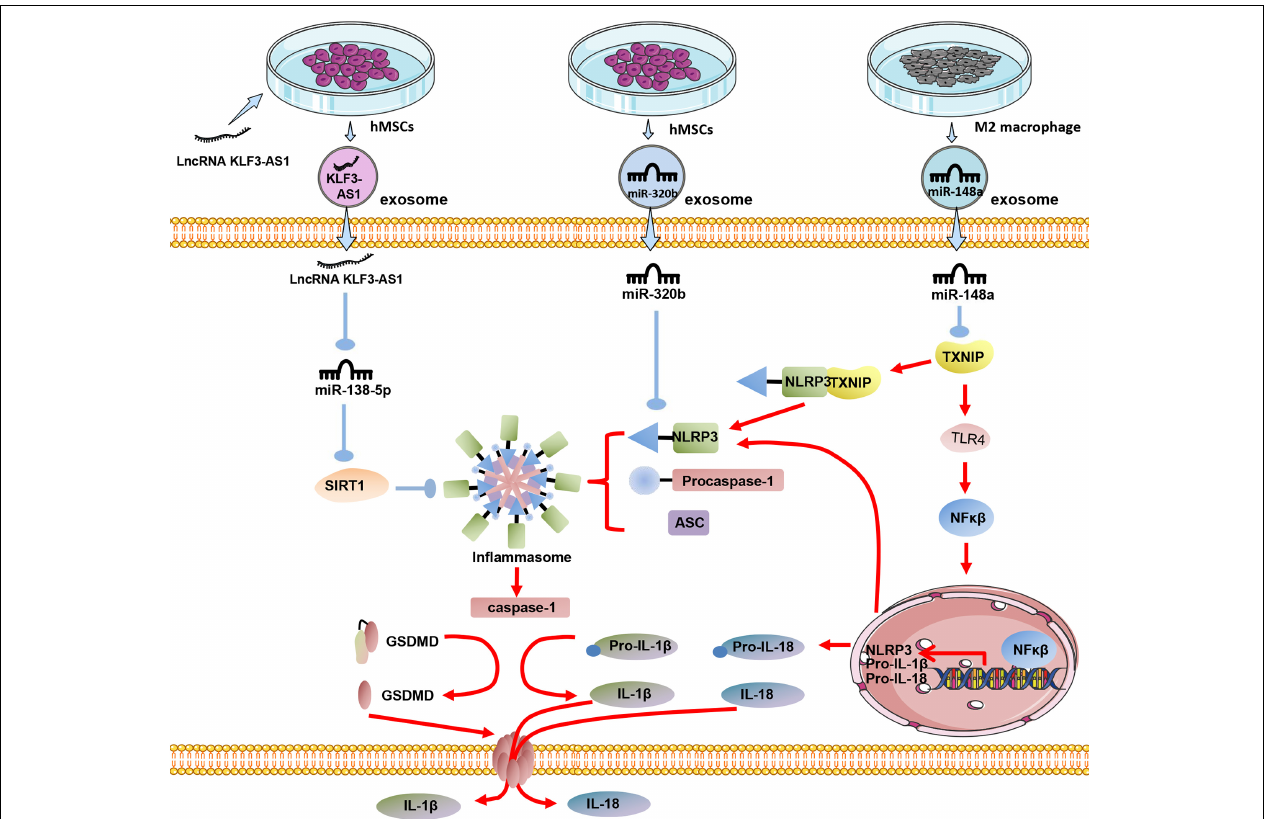
FIGURE 3 | The effect of exosomes derived from differently treated cells on the pyrolysis of cardiomyocytes after MI. Human MSCs are transfected with LncRNA KLF3-AS1, and the secreted exosomal LncRNA KLF3-AS1 are highly expressed. LncRNA KLF3-AS1 inhibits miR-138-5p then inhibits pyroptosis; Exosomal miR-320b derived from unmodified human MSCs targets NLRP3 to inhibit cardiomyocyte pyroptosis; Exosomal miR-148a in exosomes derived from M2 macrophages inhibits TXINP expression to protect against cardiomyocyte pyroptosis.